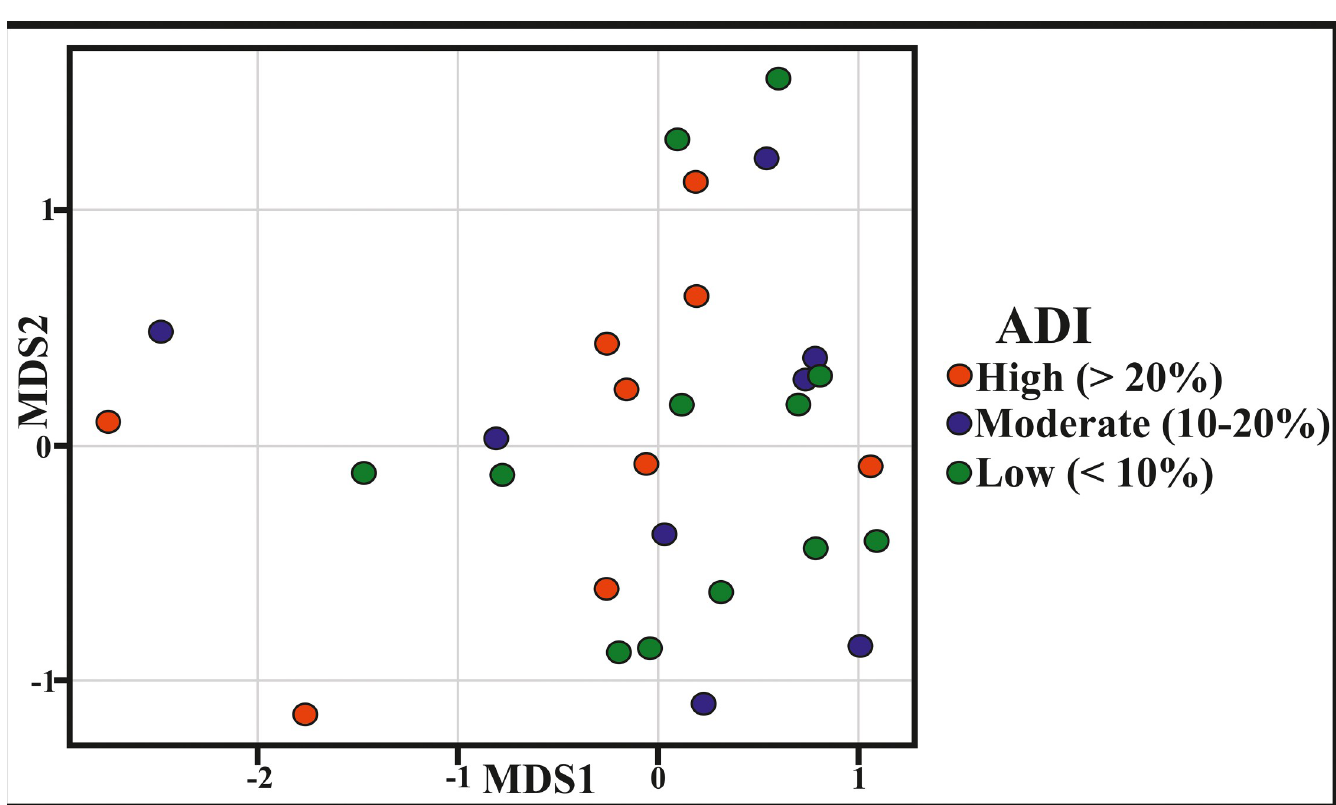
Fig 4. Non-metric multidimensional scaling with Euclidean distance (k = 2, stress = 0.15) of sampling sites shows poor clustering based on their respective molluscan assemblage drilling intensities (ADI), suggesting that although several locations have similar environments, they differ in their respective drilling